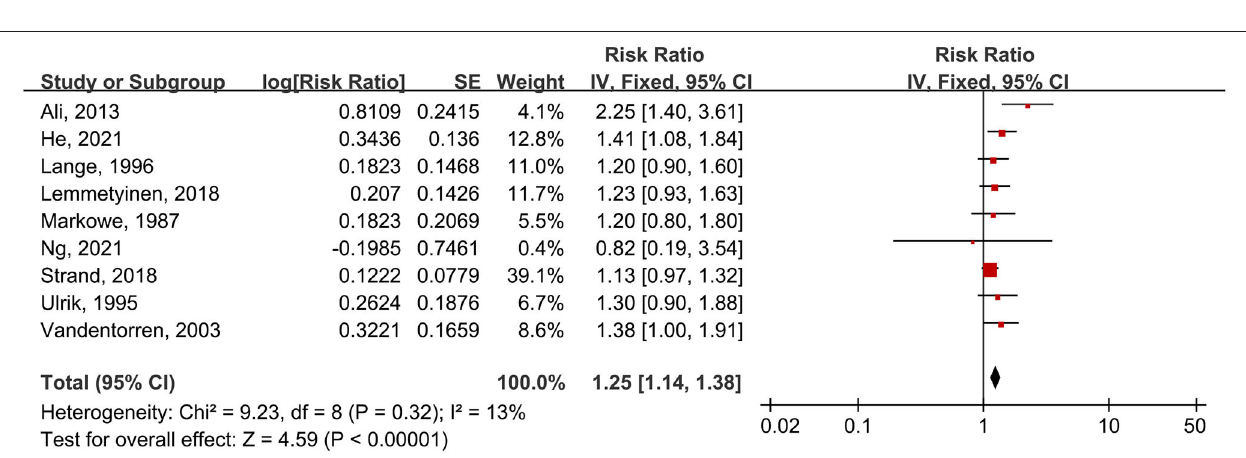
FIGURE 7 | Forest plot shows association between asthma and CVD mortality. SE, standard error; IV, Inverse Variance method; df: degrees of